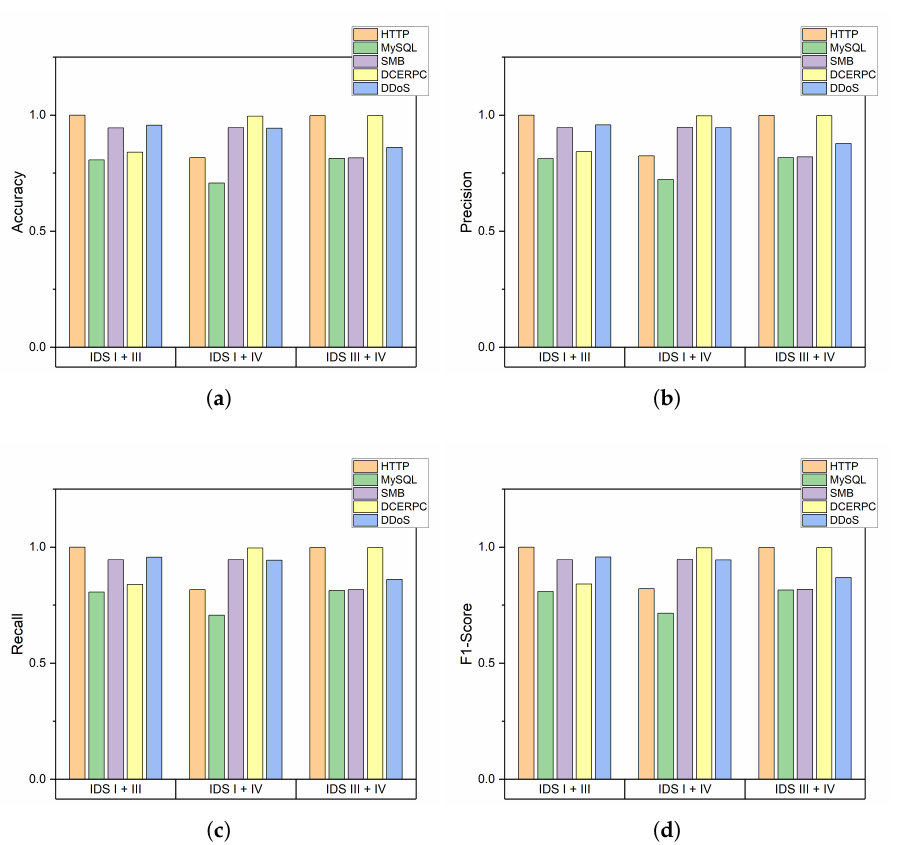
Figure 8. Performance of classification for each attack type in the setup of combination of het- erogeneous IDS: ( a ) Accuracy, Accuracy of Heterogeneous IDS field; ( b ) Precision, Precision of Heterogeneous IDS field; ( c ) Recall, Recall of Heterogeneous IDS field; and ( d ) F1-Score, F1-Score of a Heterogeneous IDS